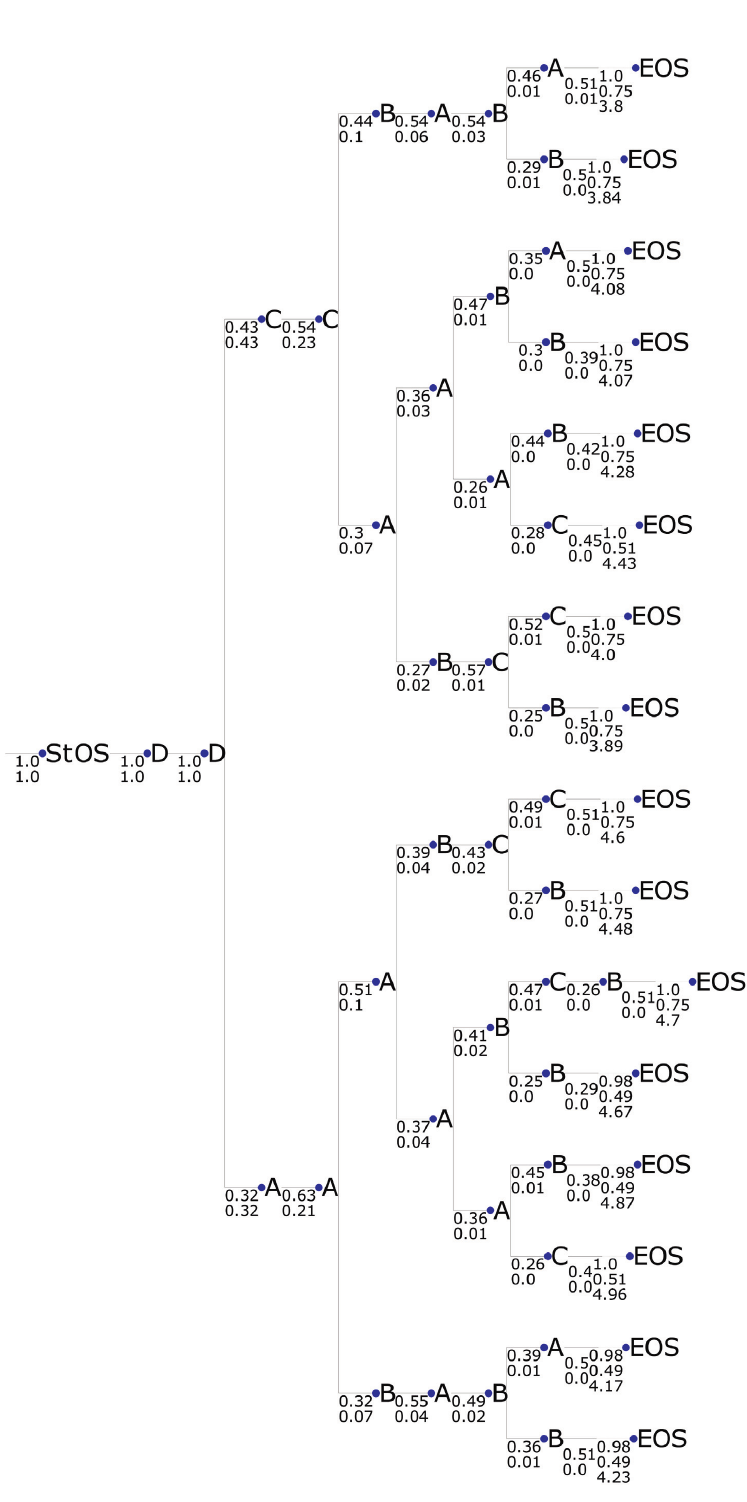
Figure 15: Output of the seq2probTree method for the tree-based system with input sequence [D